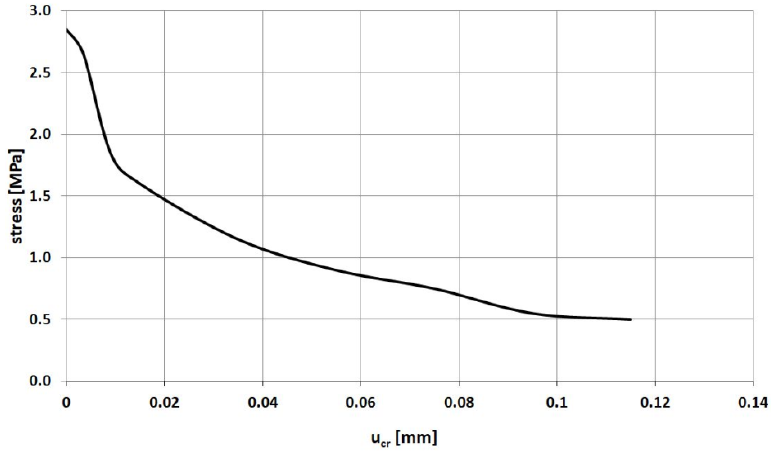
Figure 8. Crack width vs. stress relationship assumed in the uniaxial tension test.